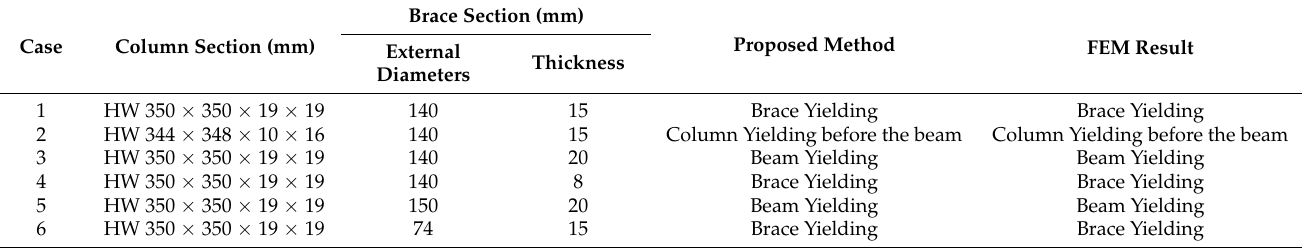
Table 4. Finite element verification results (top floor, η =